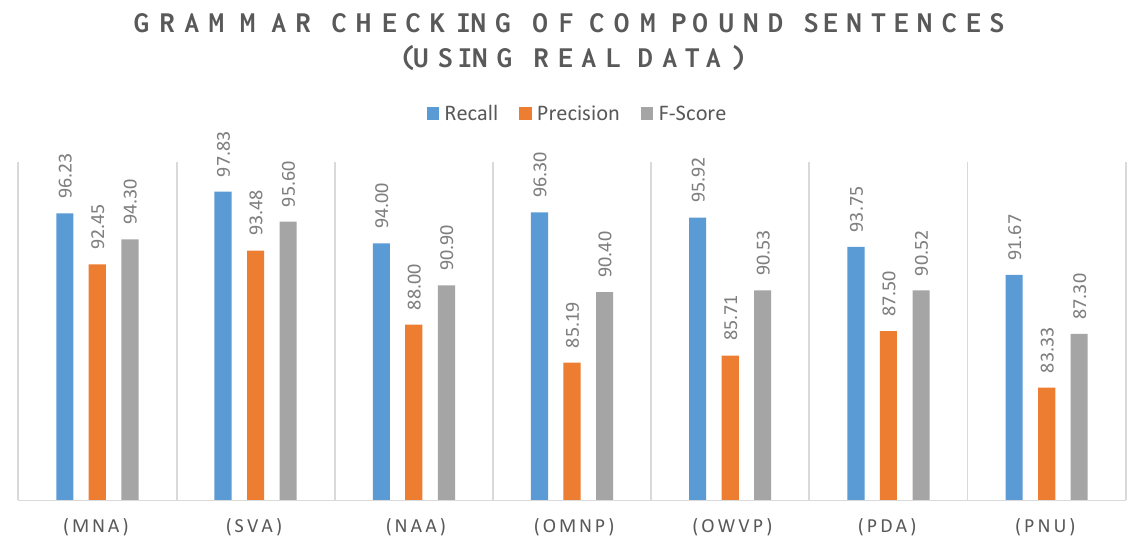
Figure 3.2 : Experimental Evaluation of Grammar checking of compound sentences (Using Real